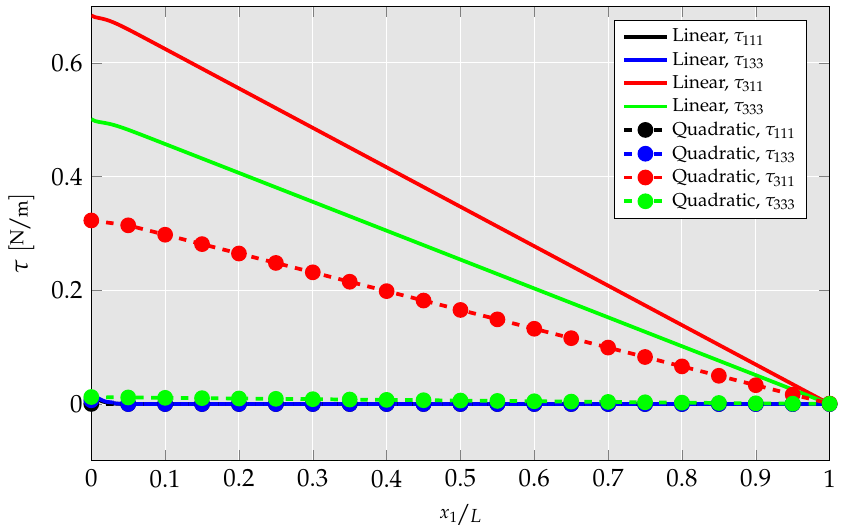
Figure 20. Comparison of higher-order stress components calculated by using linear and quadratic element along the length of the beam for prescribed mechanical